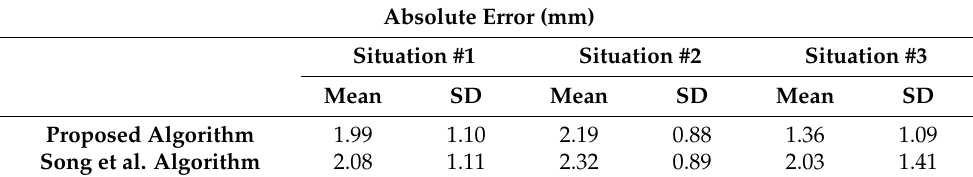
Table 2. Absolute errors in the three measurement situations shown in Figure